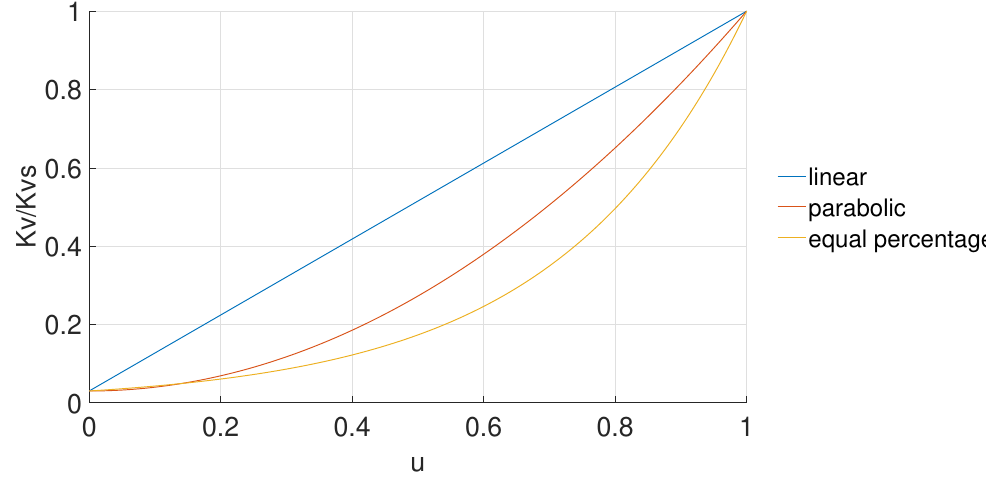
Figure 4. Characteristic valve curves.